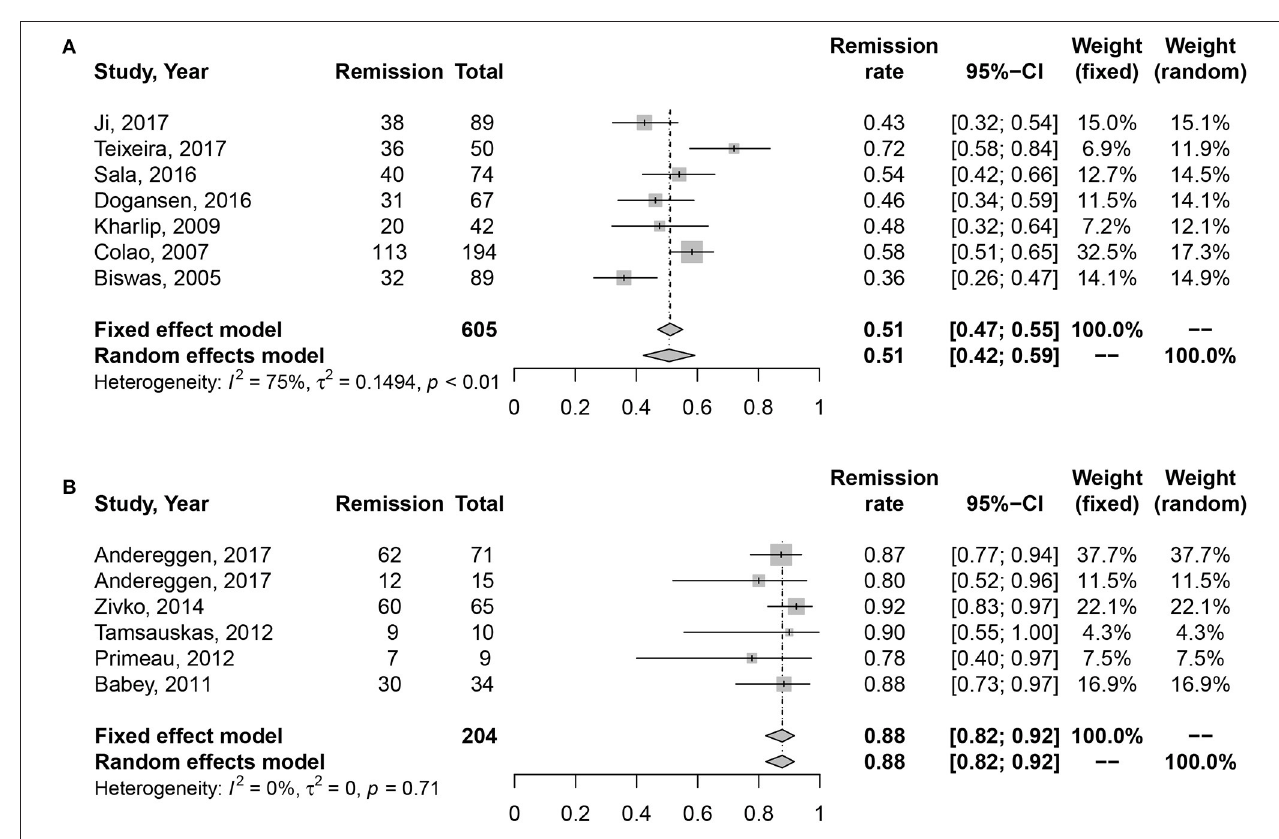
Frontiers in Endocrinology |